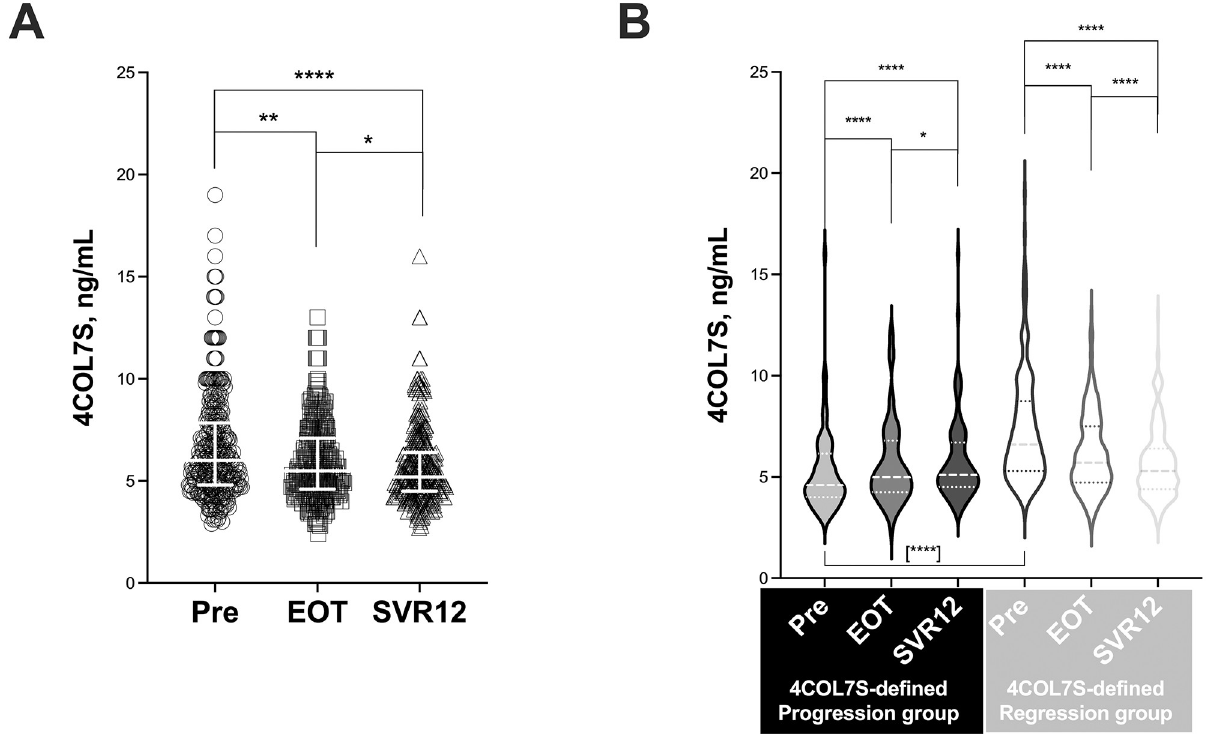
Fig 1. Peri-treatment dynamics of serum type IV collagen fragment 7S. (A) Serum levels of type IV collagen fragment 7S (4COL7S; ng/mL) just before IFN-free DAAs (Pre, circles), at the end of treatment (EOT, squares), and at sustained virological response at 12 weeks after the end of treatment (SVR12, triangles) are shown. (B) Serum levels of 4COL7S at the three timepoints in the 4COL7S-defined fibrosis progression SVR and regression SVR groups are shown as violin plots. Data are presented as median with interquartile ranges. Statistical difference between baseline levels of 4COL7S of the two groups is shown in brackets. � , P < 0.05; �� , P < 0.01; ���� , P <